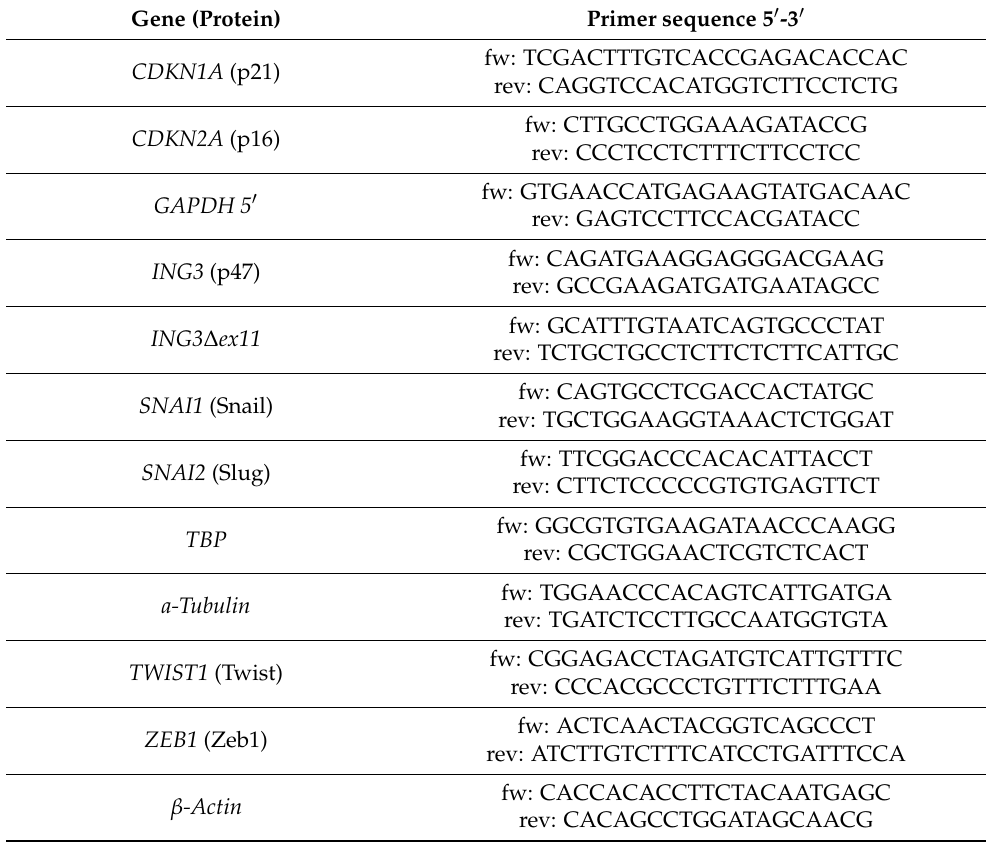
Table 1. The list of primers used for gene expression analysis in qRT/PCR.